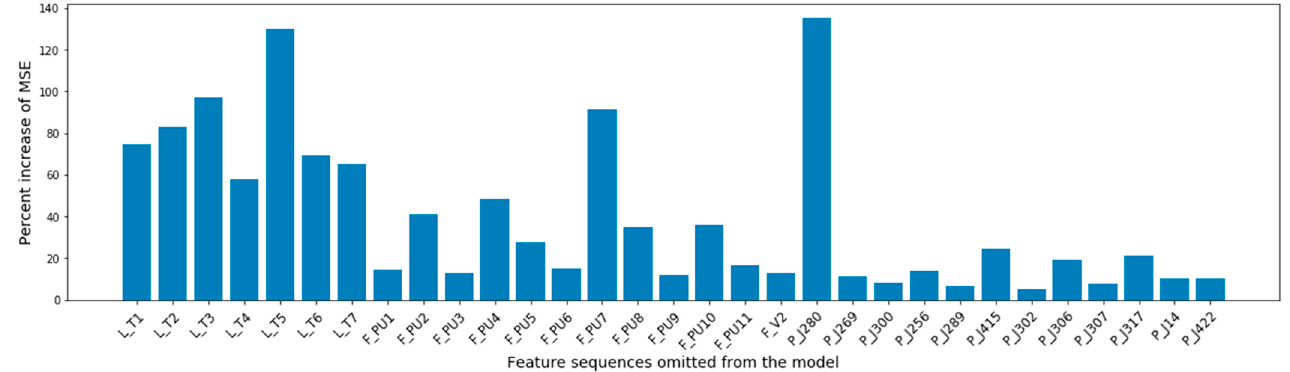
Figure 8. Feature importance summarization based on the percent increase of the MSE after each feature’s omission.